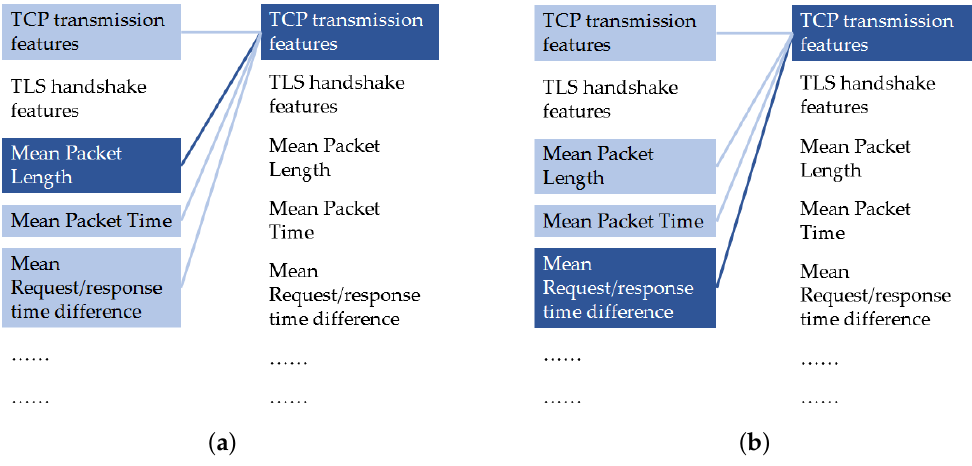
Figure 5. Interpretability of distribution of attention in machine translation: ( a ) a distribution of attention; ( b ) another distribution of attention.